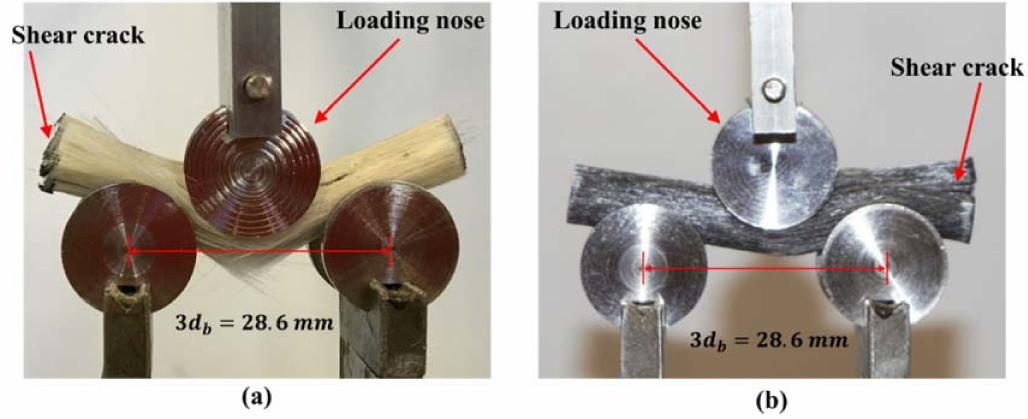
Figure 12. Short beam shear failure modes of pultruded GFRP specimens with ( a ) neat pultruded GFRP specimens and ( b ) pultruded GFRP specimens with 0.5 wt.% COOH-MWCNTs, showing shear cracks propagating in both